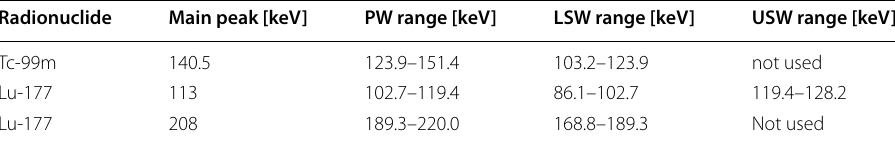
Table 3 Photopeak Window (PW), Low Scatter Window (LSW), Upper Scatter Window (USW) for 99 m Tc and 177 Lu main peaks are